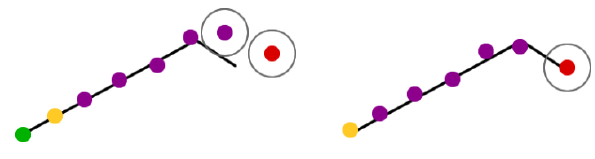
Figure 8. Invalidating a points ’ set.